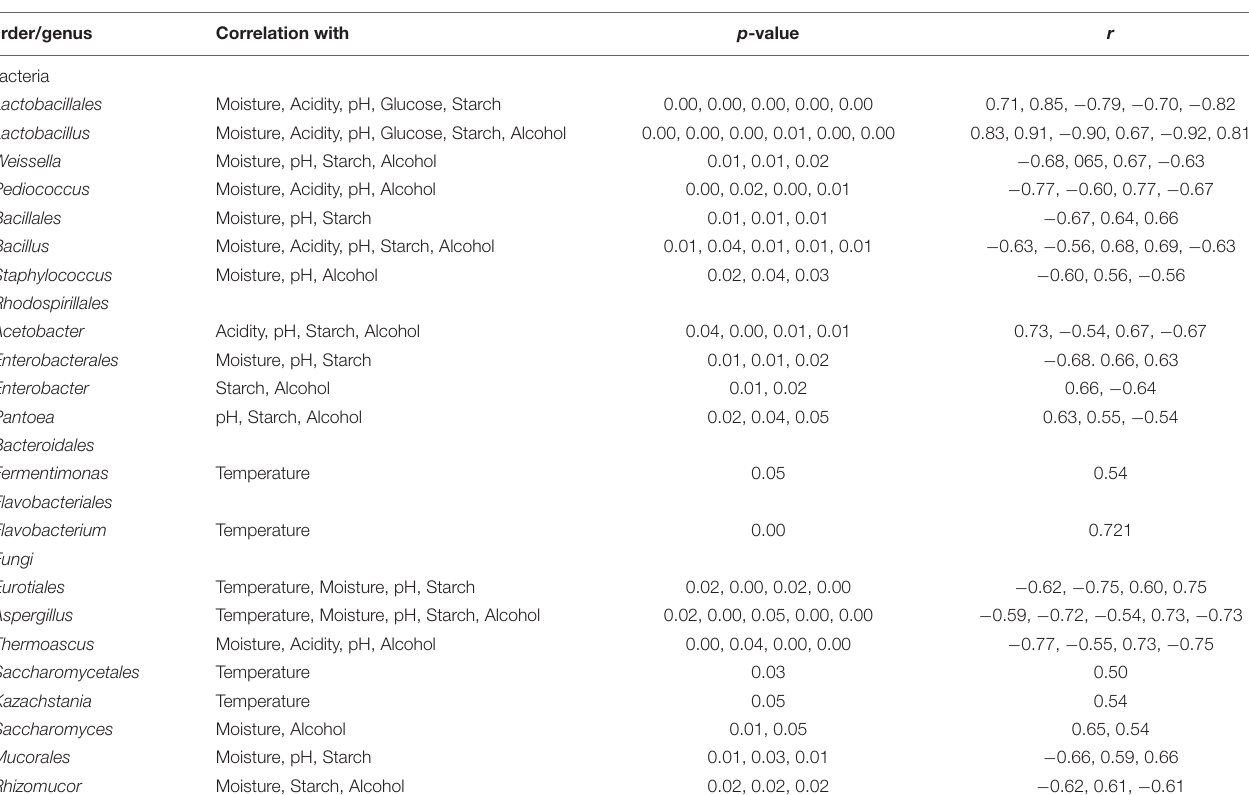
TABLE 4 | Pearson correlation coefficient ( r ) and p -value for identified bacterial and fungal orders/genera (average relative abundance > 0.5%).